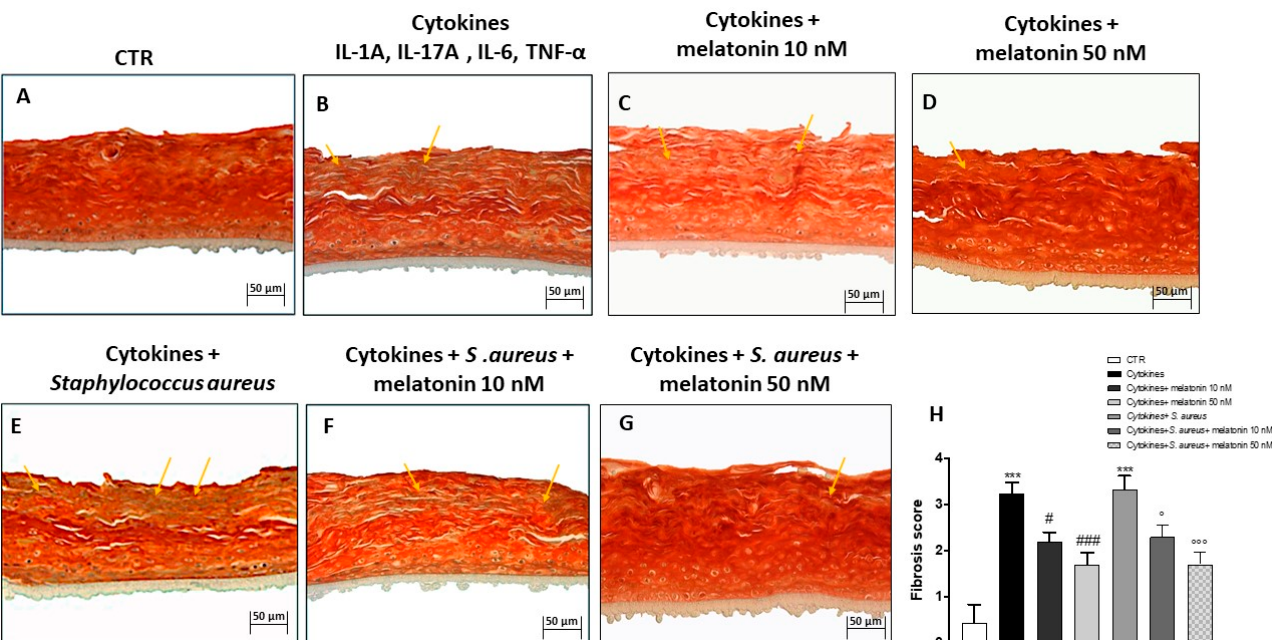
Figure 4. Effect of melatonin on keratin content. The keratin content in the control group was basal ( A ); conversely, the cytokines and S. aureus groups were characterized by an increase of keratin content ( B – E ). The treatment with melatonin at the concentrations of 10 nM and 50 nM reduced keratin content, almost to basal level ( C , D , F , G ). The yellow arrows indicate the positive staining. Data are representative of at least three independent experiments. ( H ) *** p < 0.001 vs. CTR; # p < 0.05 vs. cytokines+ group; ### p < 0.001 vs. cytokines group; ° p < 0.05 vs. cytokines+ S. aureus group; °°° p < 0.001 vs. cytokines+ S. aureus group.